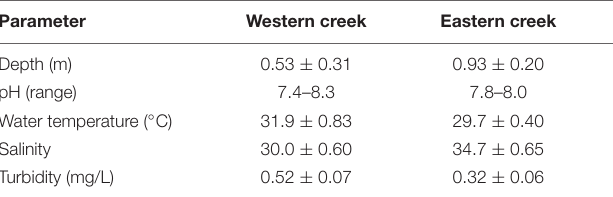
TABLE 1 | Physical–chemical parameters in the Eastern and Western creeks.